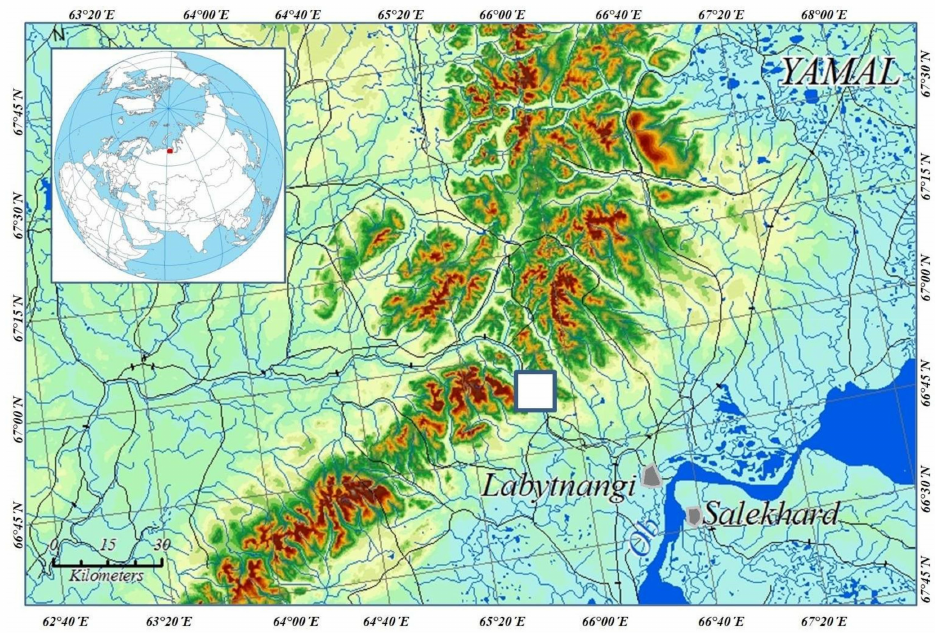
Figure 1. Map of the investigated area in the Polar Urals. The study area is marked as a white